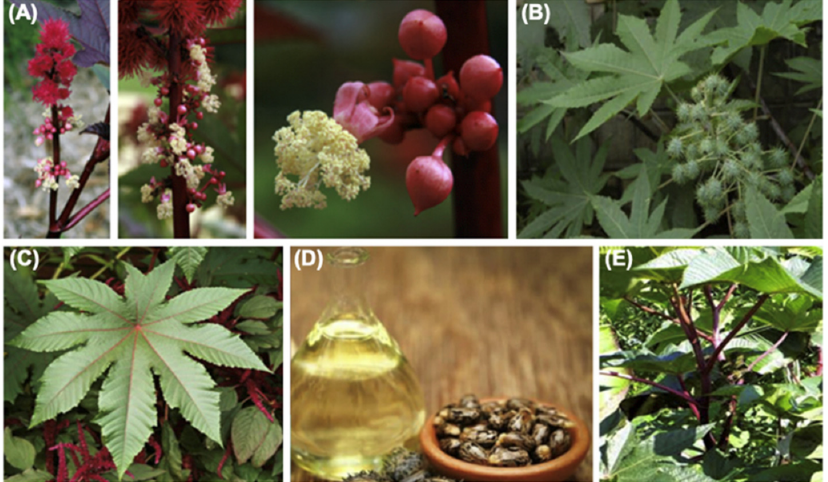
Figure 2. Castor plant ( A ) flower, ( B ) seed, ( C ) leaf, ( D ) seed and oil, and ( E ) stem (adapted from [54]). Specifically, the leaf and stem of the castor plant contain the most lignocellulosic material. Castor leaves contain 57.4 g of carbohydrate, 24.8 g of protein, 10.3 g of fiber, 5.4 g of fat, 12.4 g of ash, 2670 mg of calcium, and 460 mg of phosphorus per 100 g. Epicatechin and isoquercetin are contained in the leaves of the castor plant